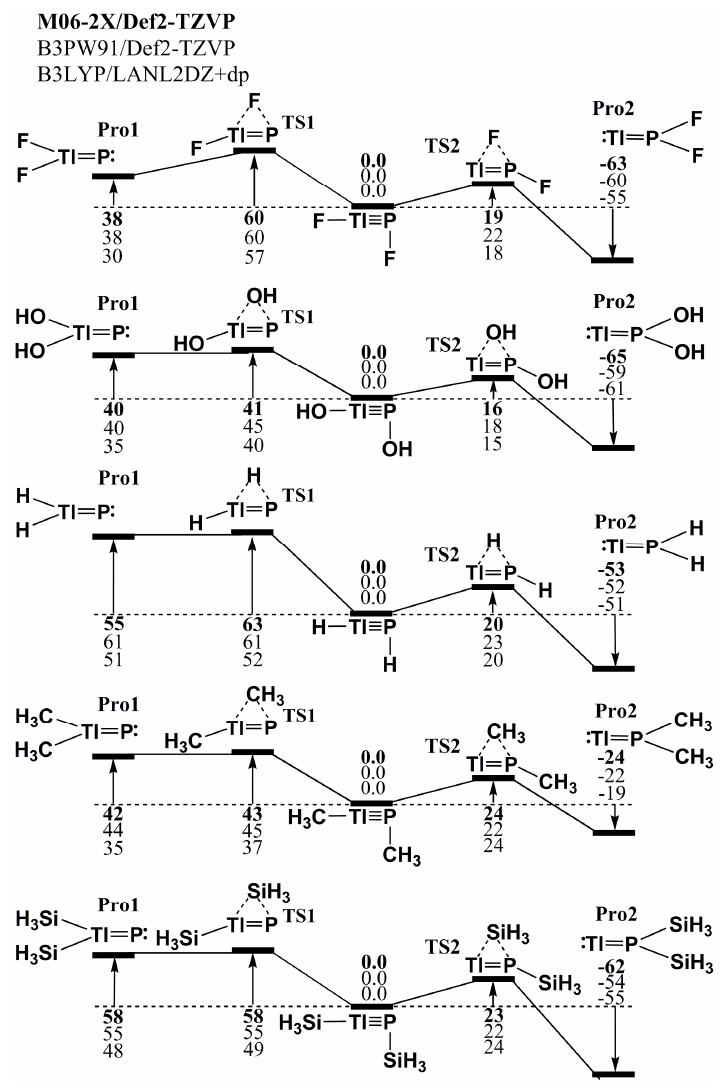
Figure 2. The Relative Gibbs free energy surfaces for RTl ≡ PR (R = F, OH, H, CH3 and SiH3). These energies are in kcal/mol and are calculated at the M06-2X/Def2-TZVP, B3PW91/Def2-TZVP, and B3LYP/LANL2DZ+dp levels of theory. For details see the text and Table 1.